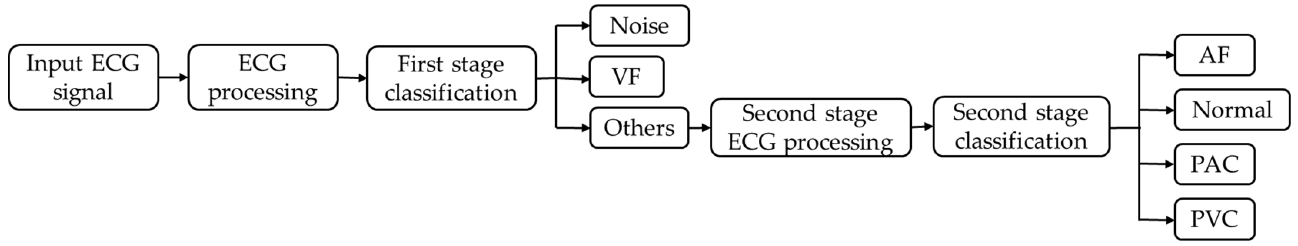
Figure 1. Diagram of the proposed